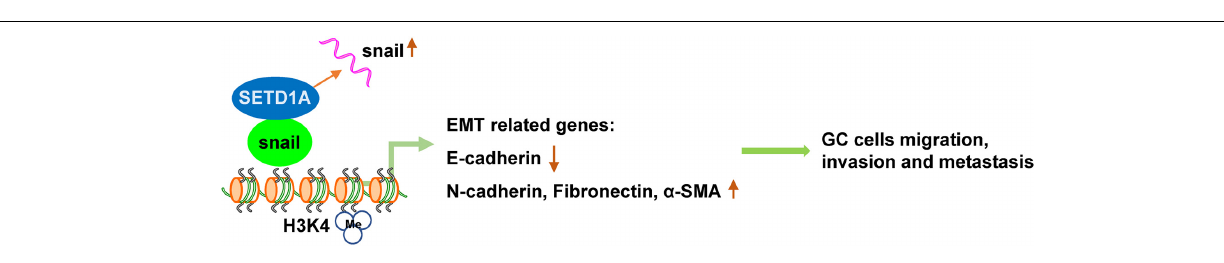
Frontiers in Cell and Developmental Biology |